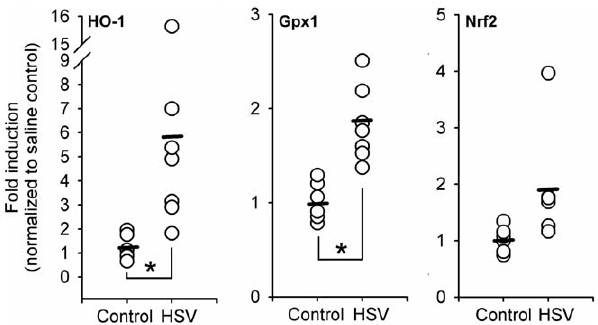
Figure 2. Antioxidant gene expression is upregulated in the brains of mice with herpes encephalitis. Balb/c mice were infected intranasally with 2 6 10 5 PFU of HSV-1 strain 17 syn + (n=7). An equal volume of saline was delivered to control mice (n=6). At 7 d p.i. mice were anaesthetized, dissected and 2 mm-thick sections of subcortical brain tissue were collected for mRNA extraction, cDNA synthesis and semi-quantitiative PCR analysis of HO-1 (*p=0.01), Gpx1 (*p=0.001), and Nrf2 expression.